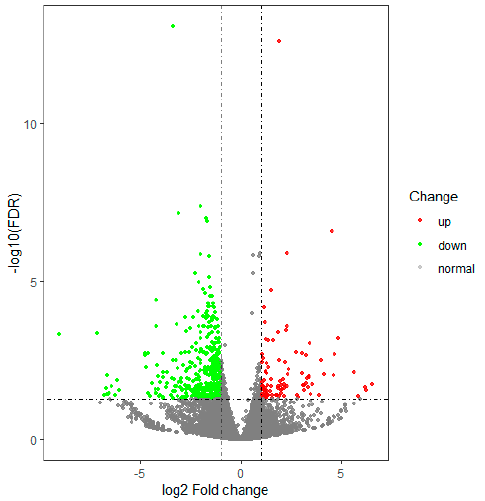
Figure 2. Volcano plot of differentially expressed genes in the control group and noise exposure group. Each dot represents an individual gene. Red dots represent significantly up regulated genes; green dots represent significantly down regulated genes.